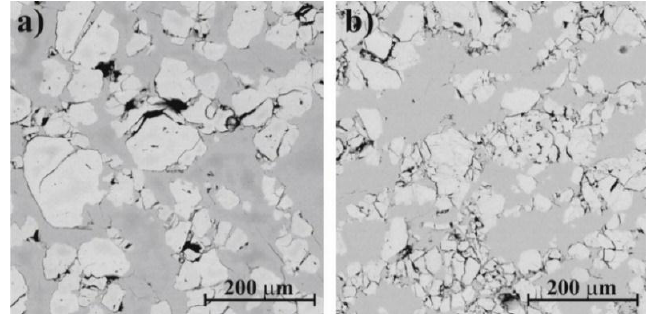
Figure 11. Cross-section of the samples after compression test ( a ) BM6; ( b ) BM9.